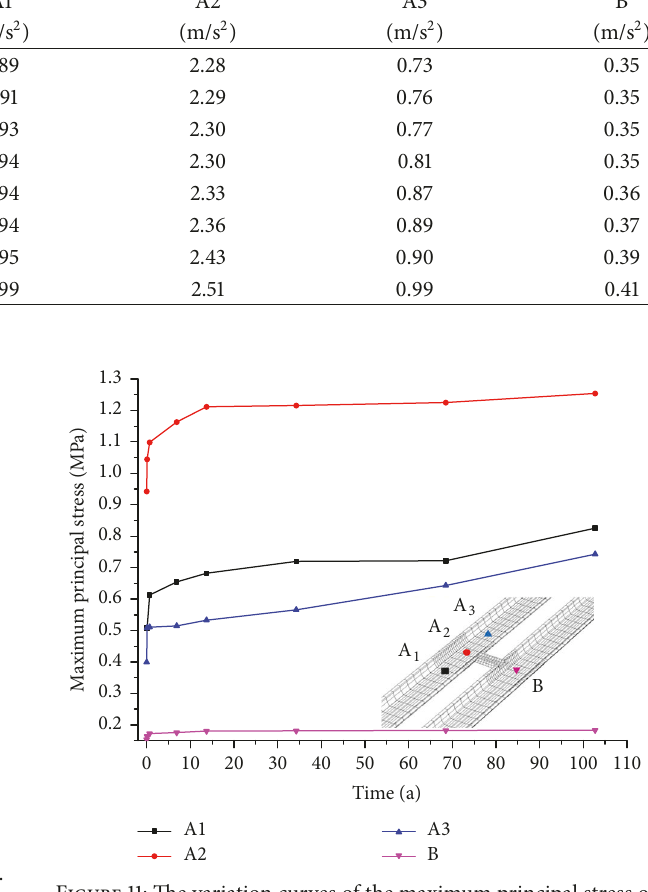
Figure 11: The variation curves of the maximum principal stress of tunnel analysis